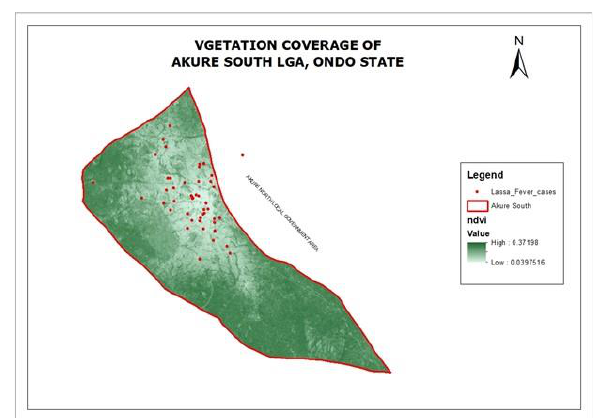
Figure 11. Map of vegetation coverage of Study